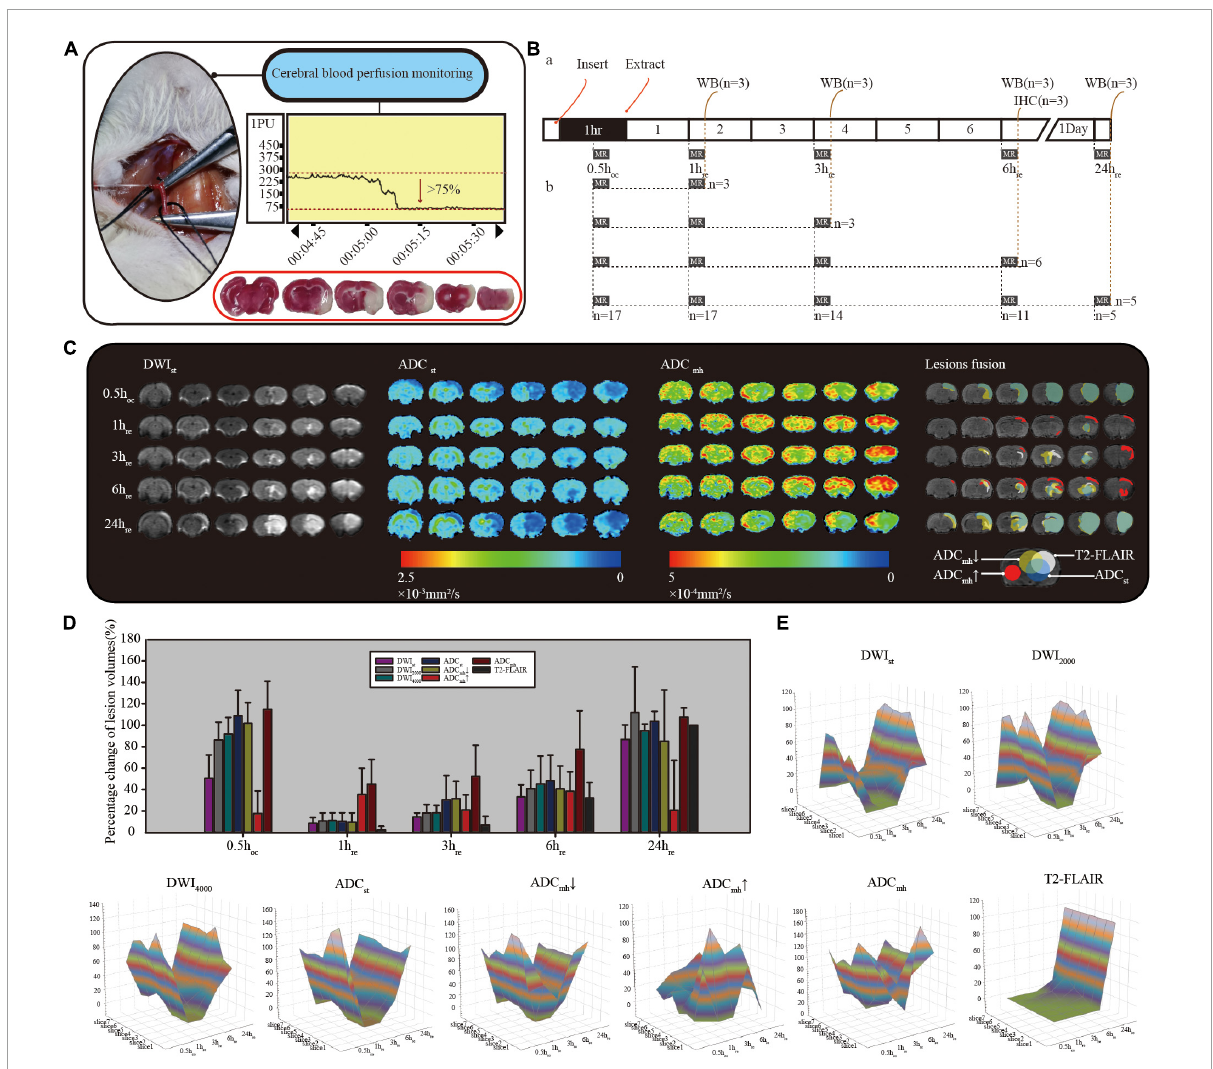
FIGURE2 (A) Criteria for successful model: a minimum initial reduction of 75% in the laser Doppler reading. 2,3,7-triphenyl tetrazolium chloride (TTC) staining is inside the red border, with normal tissue stain in red and infarction stain in white. (B) Diagram of MRI data collection and sampling of rats. (C) Comparison diagram of different sequences in single rat with consecutive MRI detection. ADC mh ↓ represents the small value on the ADC mh map, ADC mh ↑ represents the large value, and ADC mh represents all lesions with the abnormal signal. (D) Histogram of the normalized relative lesion volumes. (E) The dynamic evolution of relative lesion volumes at seven slices. All data were normalized by their respective infarction volume at 24 h on T2-FLAIR. All of the diffusion-weighted imaging (DWI) at different b -values, ADC st and ADC mh ↓ had similar lesion evolution, while ADC mh ↑ was quite